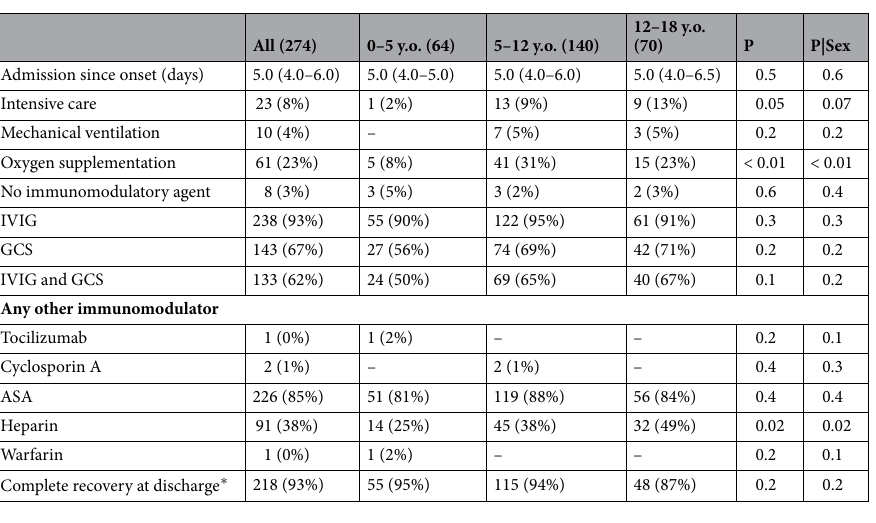
Table 5. Therapy and outcome of MIS-C cohort respective of age. Binary data given as count (per-cent), and numerical data as median (interquartile range). ASA acetylsalicylic acid, GCS glucocorticoids, IVIG intravenous immunoglobulin, y.o. years old, P|Sex sex-adjusted p-value. *All signs and symptoms resolved at